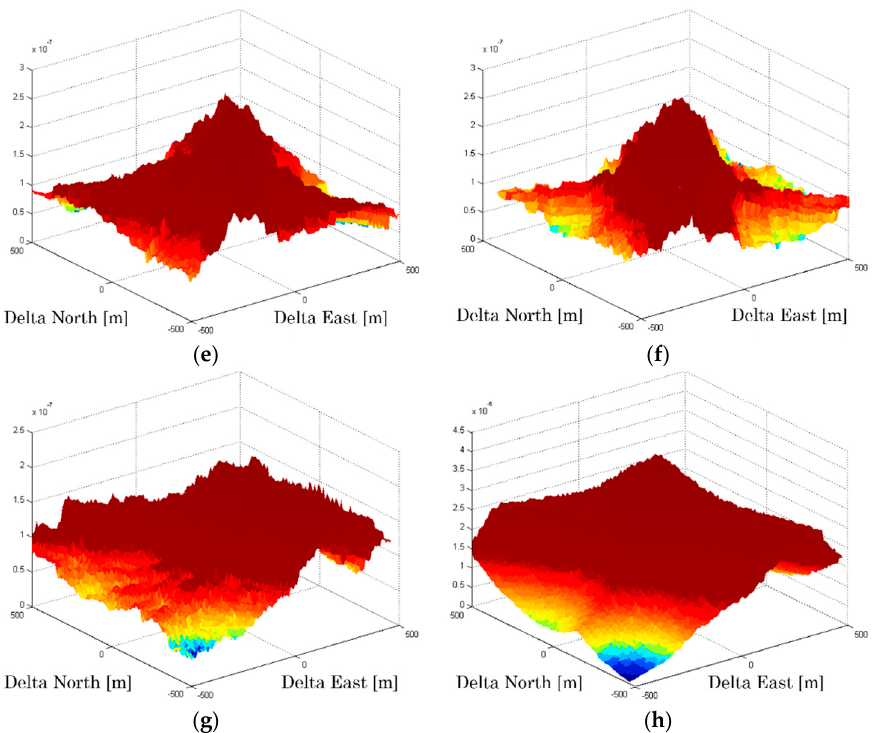
Figure 3. Influence on CD positioning ambiguity. ( a ) 6 satellites, mask = 10°, GDOP = 1; ( b ) 10 satellites, mask = 10°, GDOP = 1; ( c ) 6 satellites, mask = 10°, GDOP = 2.5; ( d ) 10 satellites, mask = 10°, GDOP = 2.5; ( e ) 6 satellites, mask = 30°, GDOP = 2.5; ( f ) 10 satellites, mask = 30°, GDOP = 2.5; ( g ) 6 satellites, mask = 30°, GDOP = 10; ( h ) 10 satellites, mask = 30°, GDOP = 10.